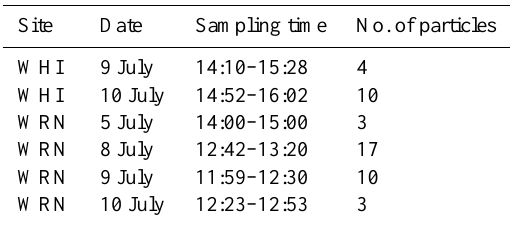
Fig. 5. Contributions from each PMF factor to the organic aerosol mass at WHI and WRN for the whole campaign, and for the four sub-periods. The indicated concentration above each pie chart represents the average organic concentration for the specific period and site. Table 2. Description of STXM samples.